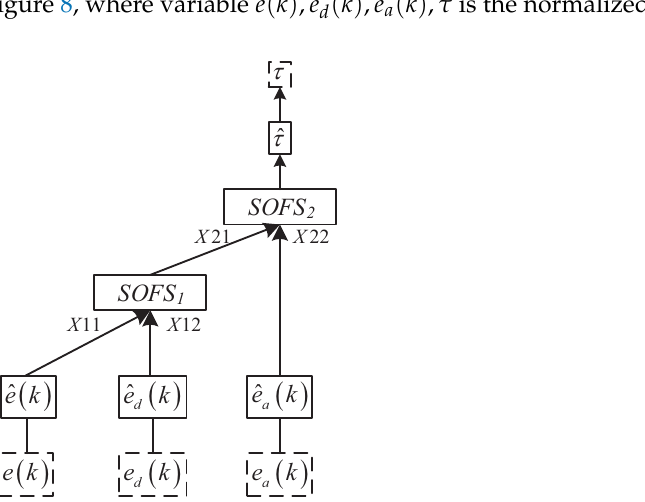
Figure 2. The normalized algorithm structure has two additional modules: the normaliza- tion of the input data and denormalization of the output data. The structure is shown in Figure 8, where variable ˆ e ( k ) , ˆ e d ( k ) , ˆ e a ( k ) , ˆ τ is the normalized variable.